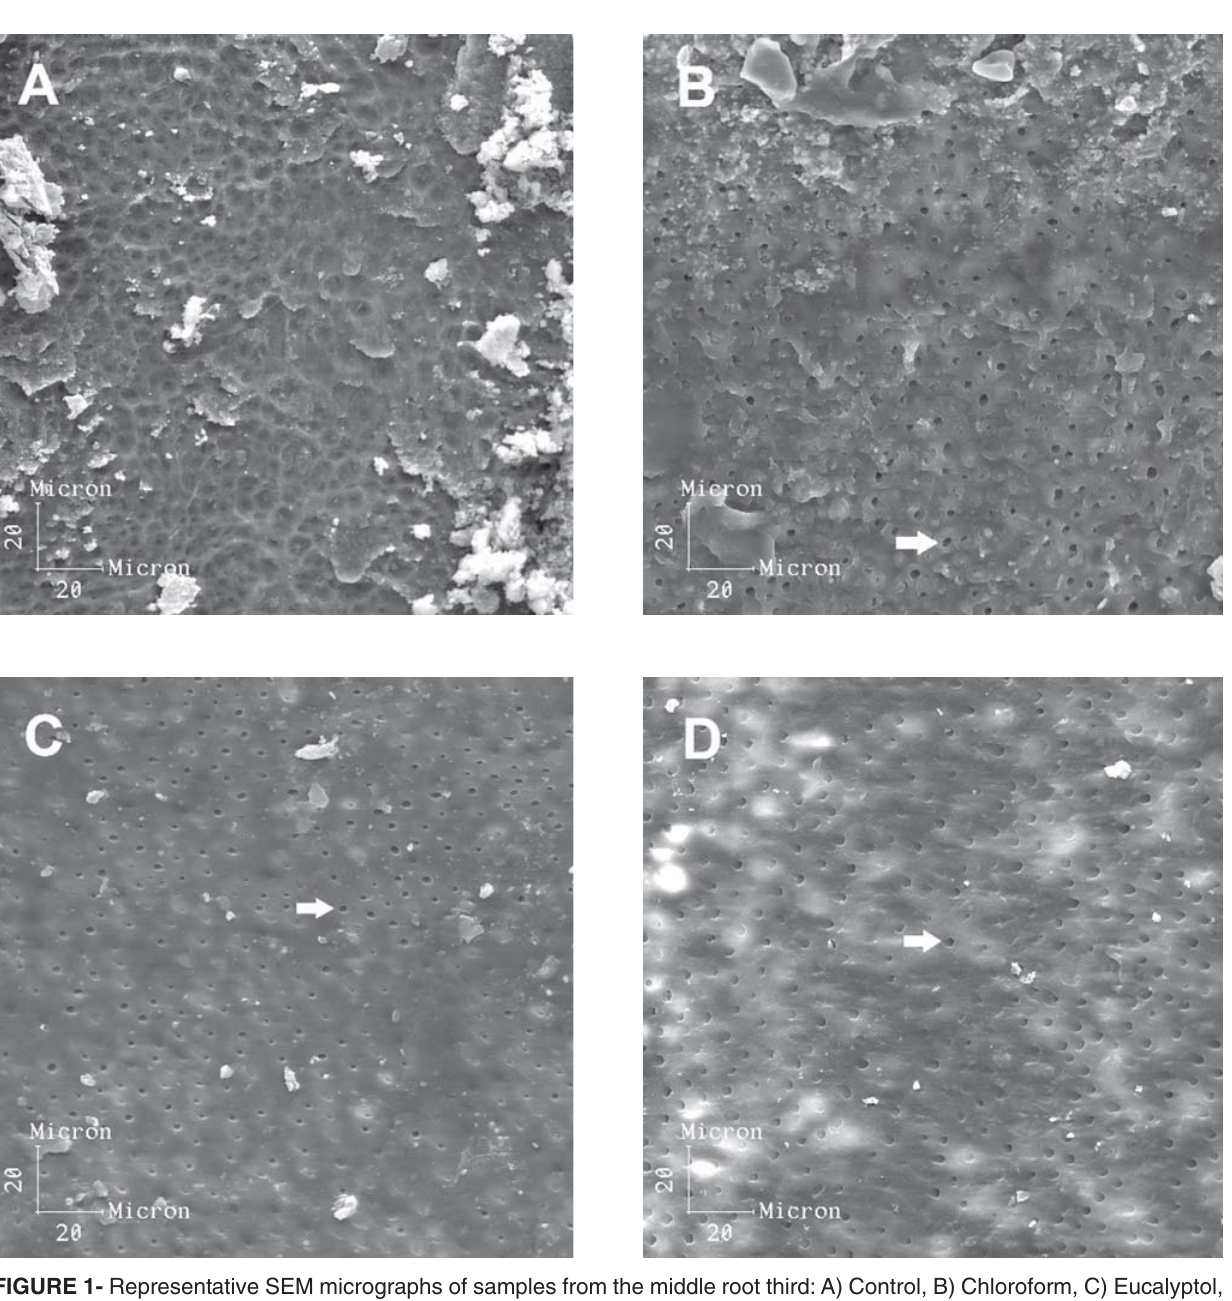
*, **: No statistically significant difference (p>0.05) using Kruskall-Wallis